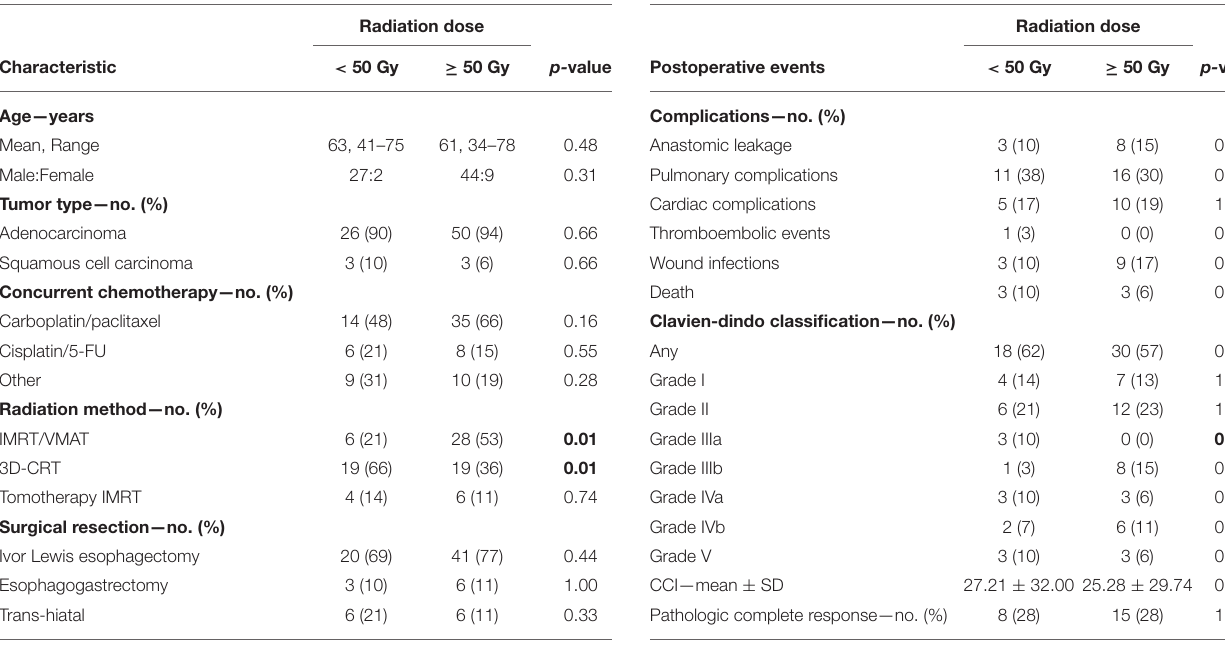
TABLE 2 | Post-operative events and radiation dose.